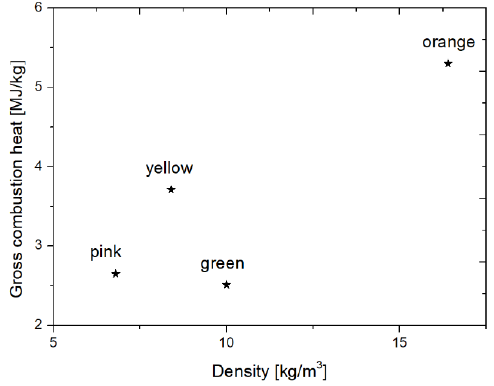
Figure 8. The gross combustion heat of the samples.